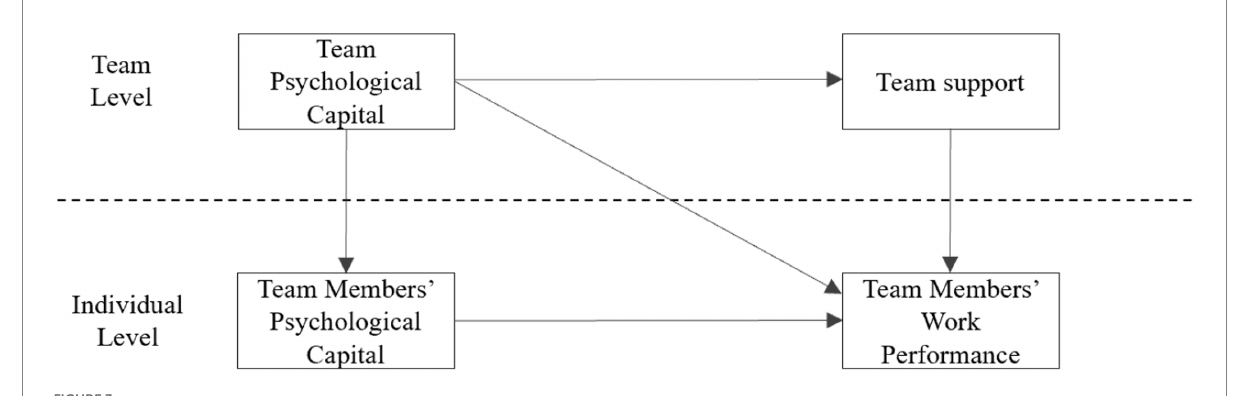
FIGURE 3 The mediating role of team support between team psychological capital and team members’ work